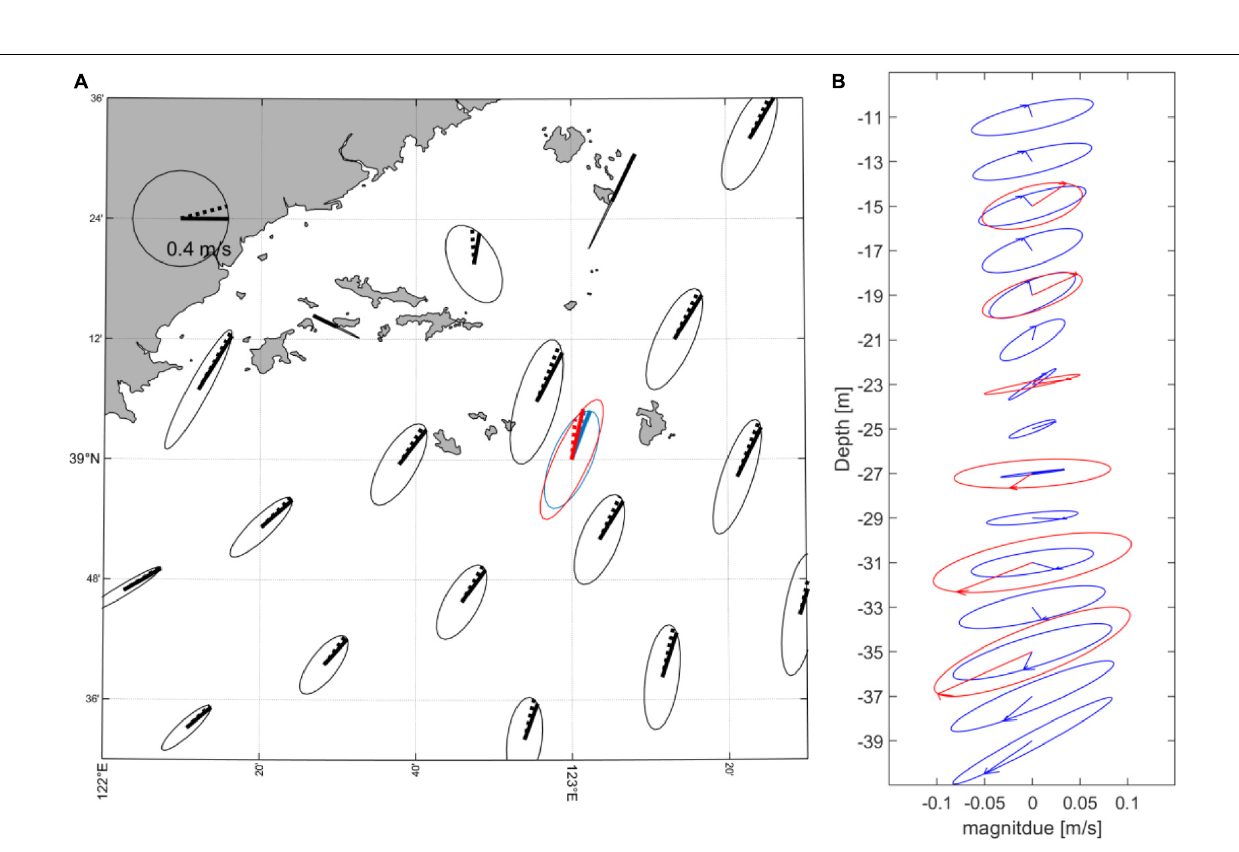
Frontiers in Marine Science |